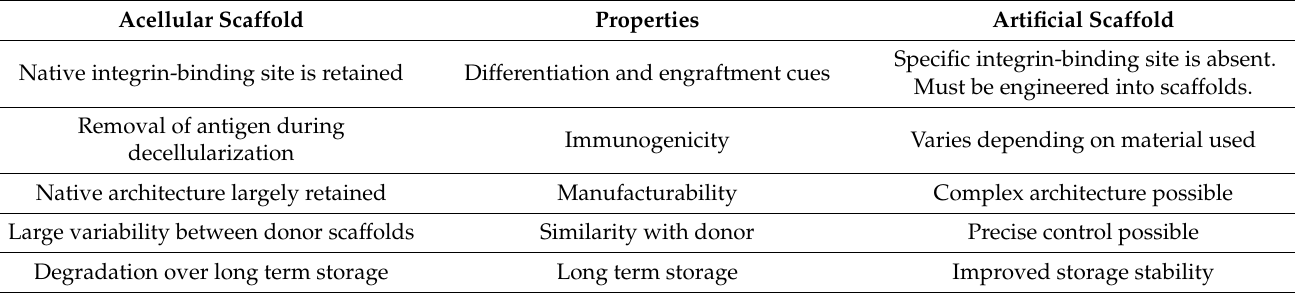
Table 1. Differences between properties of acellular and artificial scaffolds. Acellular Scaffold Properties Artificial Scaffold Specific integrin-binding site is absent. Differentiation and engraftment cues Must be engineered into